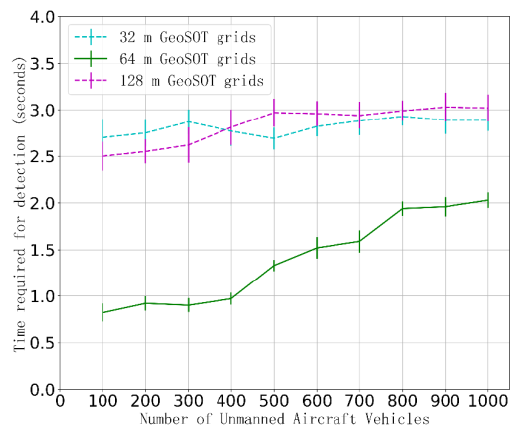
Figure 6. Time required for detection with di ff erent GeoSOT-3D grid sizes. The three selected GeoSOT-3D grid sizes are 128 m, 64 m, and 32 m, which correspond to levels 19, 20, and 21,